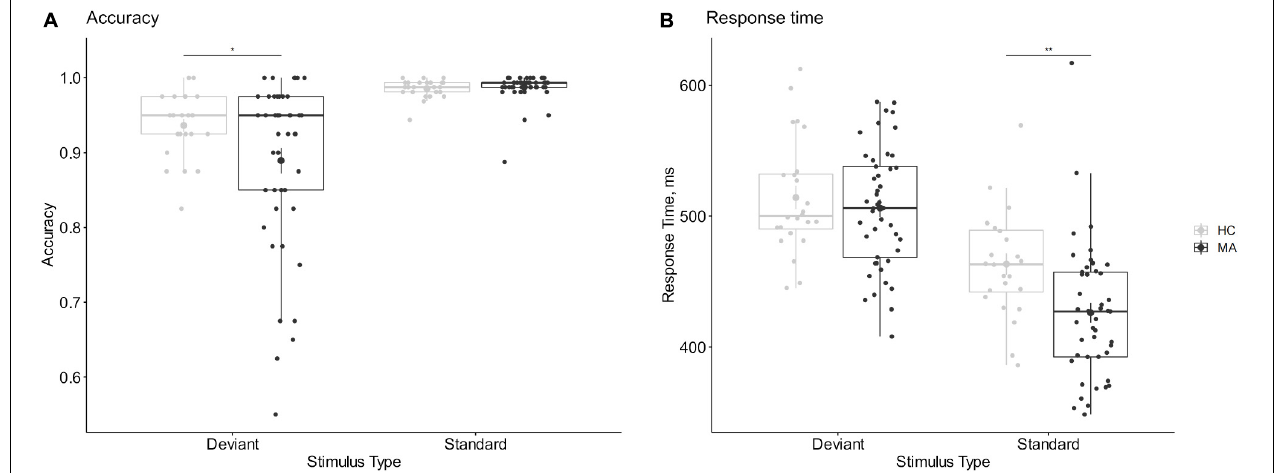
FIGURE 2 | Comparison of behavioral impulsivity between methamphetamine addicts and healthy controls. (A) The accuracy of 2-choice oddball task. (B) The response time of 2-choice oddball task. (A) The accuracy of 2-hoice oddball. (B) The response time of 2-choice oddball. MA refers to methamphetamine addicts, HC refers to healthy controls. *Refers to 2-sided p < 0.05. **Refers to 2-sided p < 0.01. Error bars show the standard error of the mean. Enlarged dots refer to means.